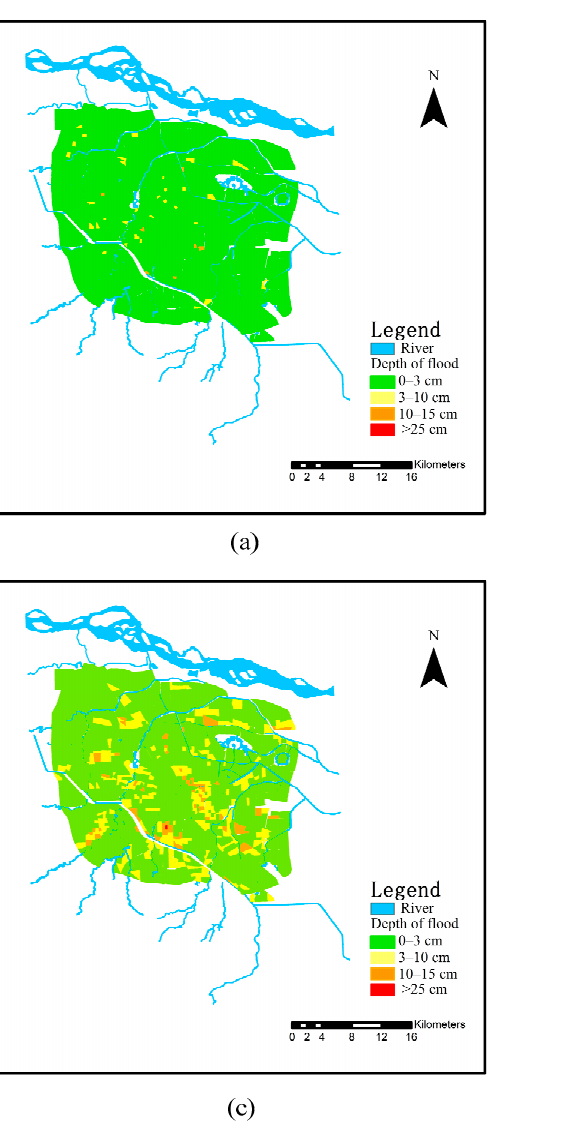
Figure 6. The urban inundation map under different designs of rainfall return periods: ( a ) 0.5a, ( b ) 1a, ( c ) 2a, ( d ) 5a. According to the results (Figures 6 and 7), with an increase in the rainfall return pe- riod, Zhengzhou city will experience an increasing trend in the number, depth, and sur- face area of the water accumulation area. In the scenario of the semi-annual rainfall re- currence period, water accumulation is predicted to occur in 47 regions, among which 36 were in the 3–10 cm class, 8 were in the 10–25 cm class and no region had more than 25 cm of flood. In the once-a-year rainfall return period, the number of estimated flooded areas increased to 131 (100 at 3–10 cm, and 29 at 10–25 cm). In the once-every-two-years